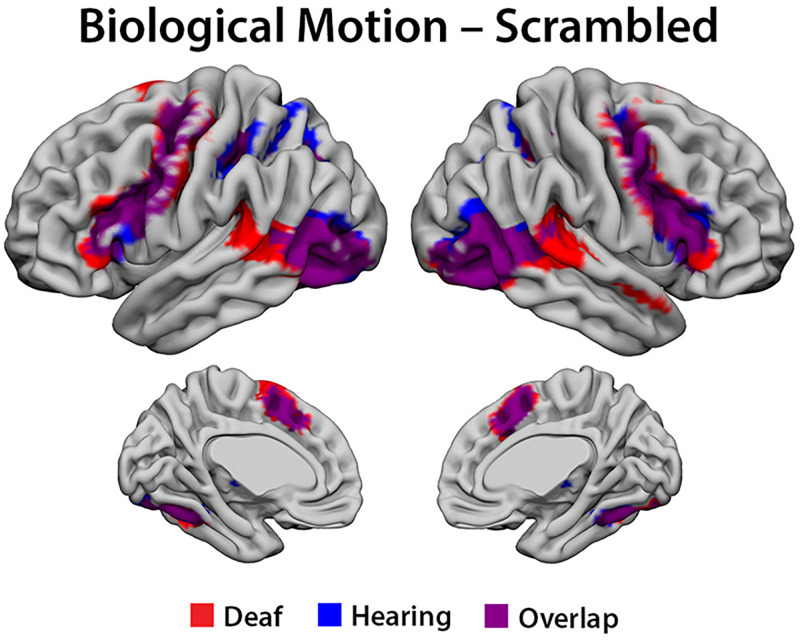
fMRI data.The conjunction of cortical activations implicated in biological motion processing [(Emblems + Pantomimes)—scrambled] by the group, deaf (Red) and hearing participants (Blue), Overlap (Purple).